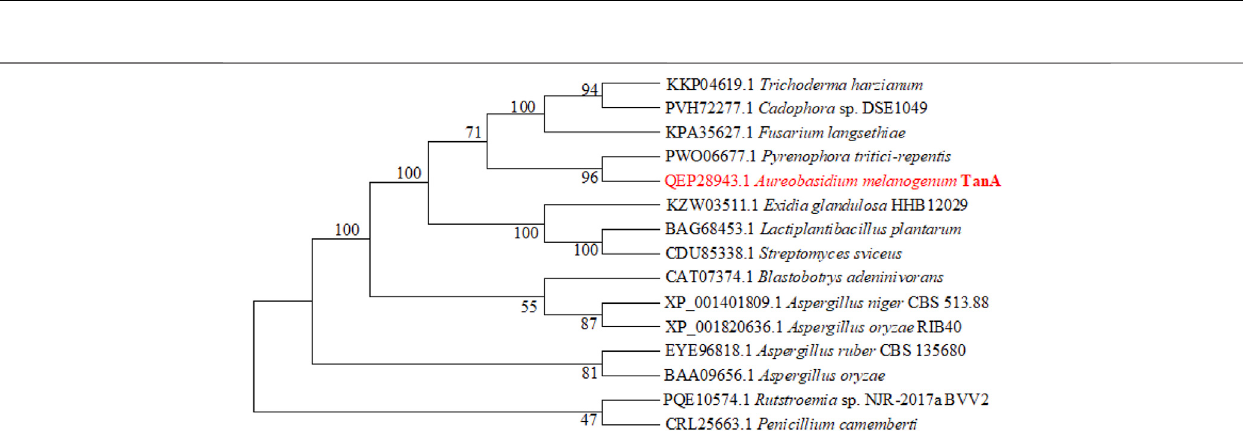
Frontiers in Bioengineering and Biotechnology |